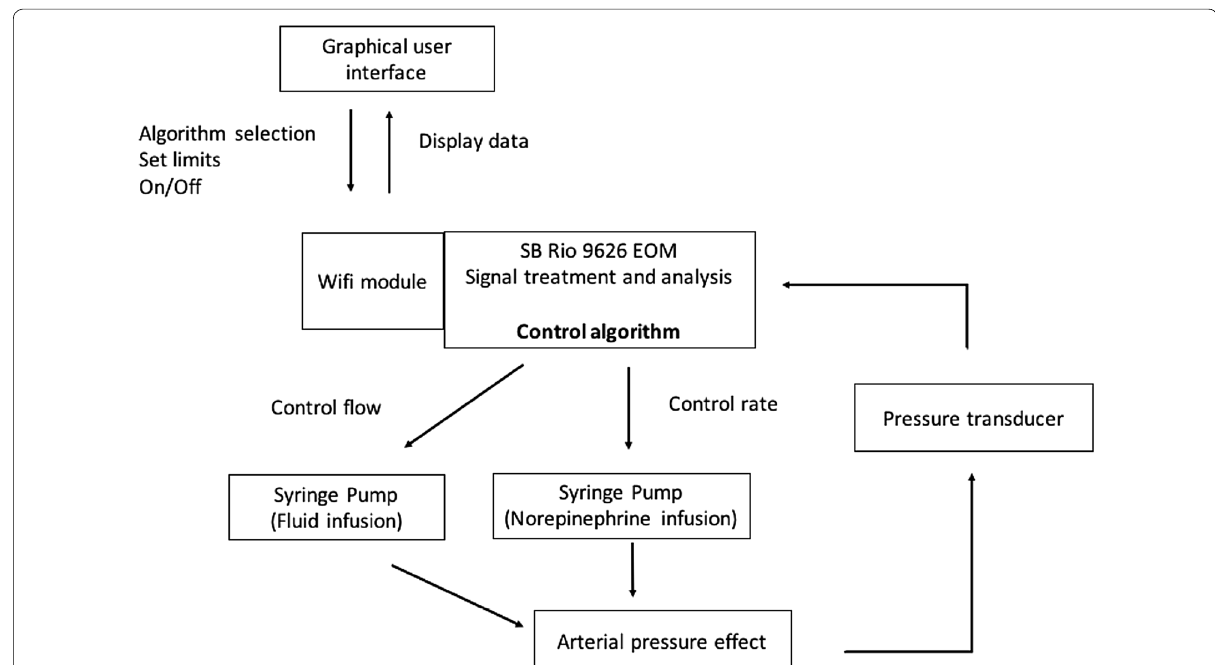
Fig. 2 Schematic of the system set-up. The CL-FNE combined a PI regulator for fluid and a FL regulator for NE. Several conditional rules were included to mimic the physician decisions. The algorithm needed three variables: systolic arterial pressure, systolic arterial pressure error and time. During resuscitation, it calculates the ratio of fluid volume/norepinephrine to adapt